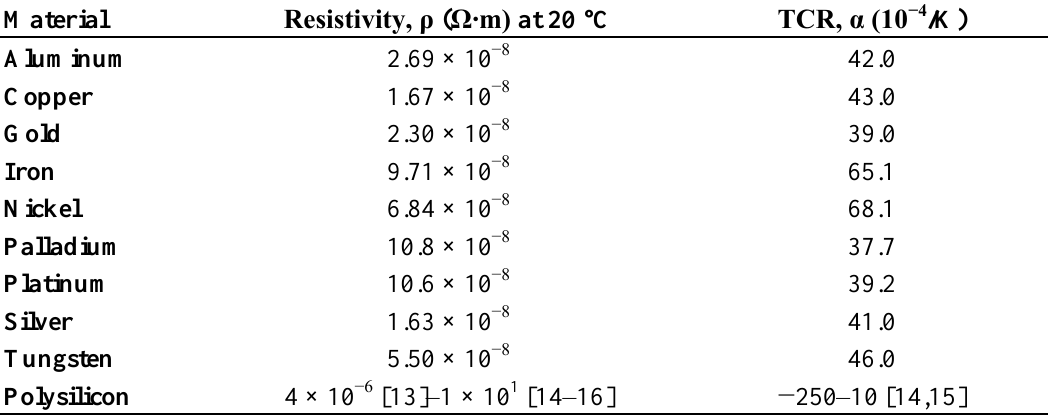
Table 1. Relevant electrical and thermal properties of thermal flow sensor materials